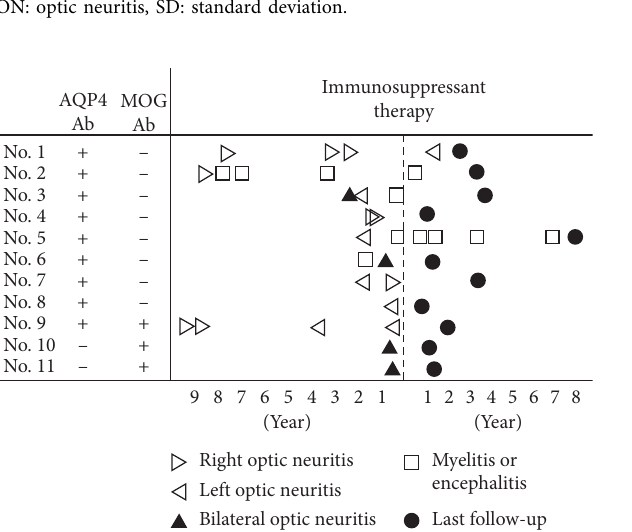
Figure 1: A summary of the treatment history, relapses, and treatment of all 11 patients in the study. Initial onset of ON was not included in the determination of number of relapses in the study. AQP4: anti-aquaporin4 antibody; MOG: anti-myelin oligoden- drocyte